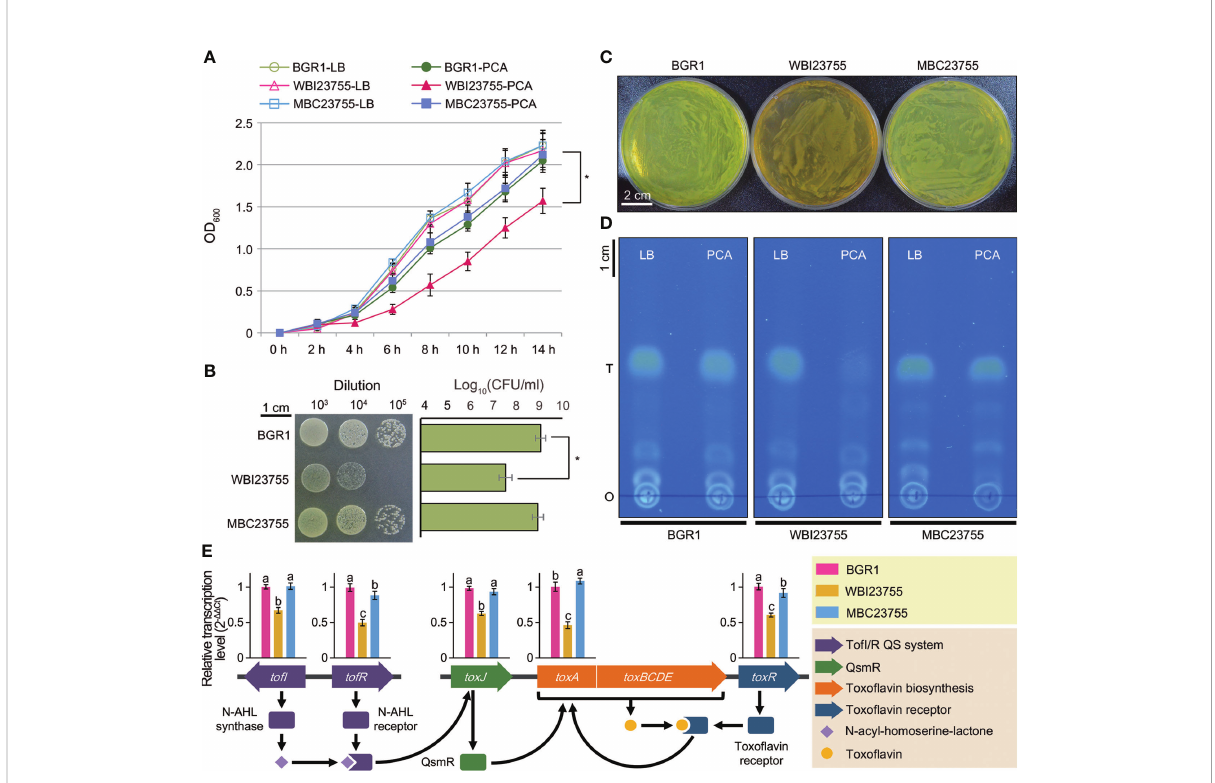
FIGURE 6 Phenotype assays of the WBI23755 mutant in the presence of PCA (A) The growth of each strain was monitored in LB broth with and without PCA. OD 600 values were measured at 2 h intervals over a period of 14 h. Error bars represent the standard errors from three independent experiments. The asterisk represents a signi fi cant difference between samples (Student ’ s t -test P ≤ 0.05). (B) A spot dilution assay was conducted on LB agar plates supplemented with PCA. Bacterial cultures were serially diluted, and a 10- m l aliquot was dropped for each spot. A photograph was acquired after 24 h of incubation at 37°C. Each row and bar represents the mean of log(CFU/ml) and the standard error, respectively. (C) The pigmentation of the WBI23755 mutant was evaluated in the presence of PCA. Agar plates were acquired after 24 h of bacterial incubation at 37°C. The yellow pigment of BGR1 is toxo fl avin. An uninoculated sample served as a negative control. (D) The quantitative level of toxo fl avin was determined by a TLC assay. Toxo fl avin produced by each strain was collected from LB broth and LB broth with PCA. A TLC plate was photographed under UV light at 365 nm (o: origin; T: toxo fl avin). (E) The effect of PCA on the expression of major genes ( tofI , tofR , toxA , toxJ , and toxR ) of toxo fl avin biosynthesis was analyzed by qPCR. The schematic diagram illustrates the distribution of genes and their regulation system for toxo fl avin biosynthesis in ( B ) glumae . The relative transcription levels were calculated using the 2 − DD Ct method and are presented above each gene. Error bars represent the standard errors from three replicates. Different lowercase letters above the error bar indicate statistical signi fi cance at P ≤ 0.05 according to the least signi fi cant difference test. In all assays, the concentration of PCA was set to 1 mg/ml, and the MBC23755 strain was used as a positive